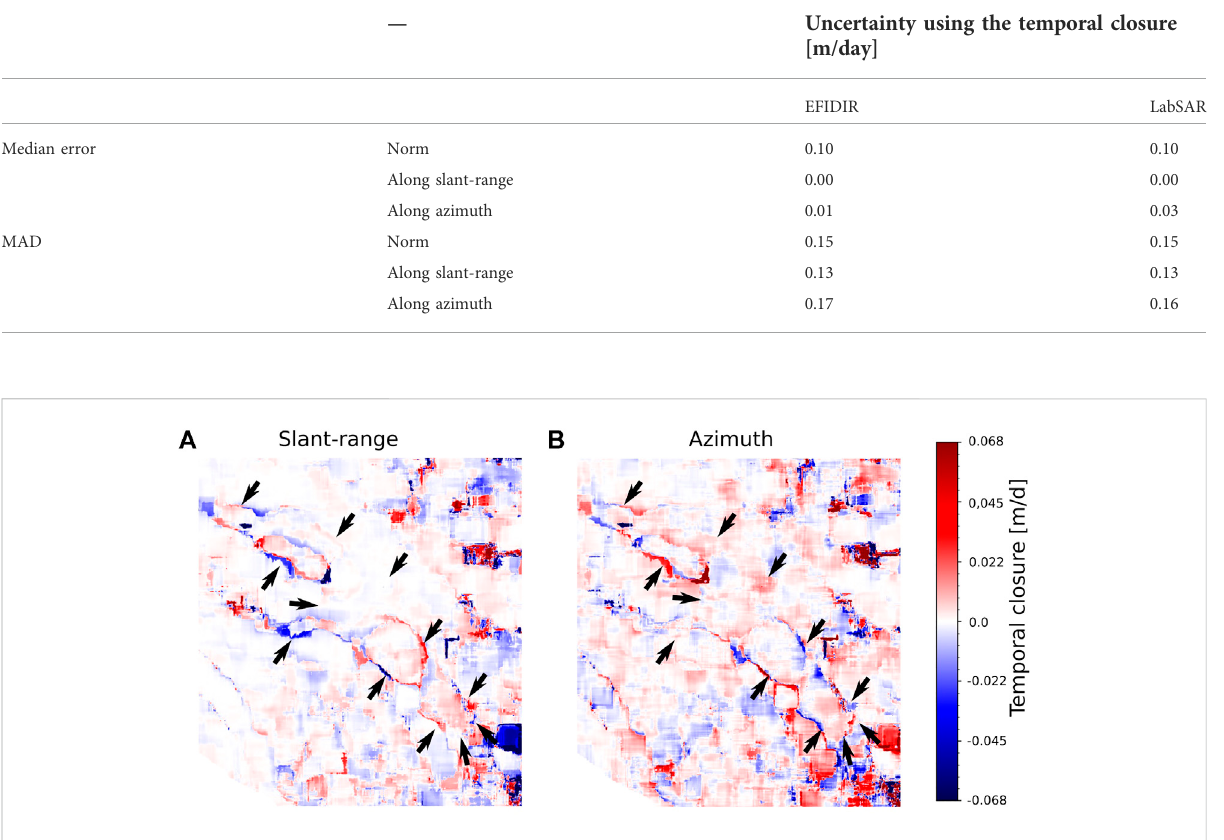
TABLE 4 Comparison of the MAD and MdE of the temporal closure of the displacements for the slant-range and azimuth direction computed using the EFIDIR and LabSAR approaches. The norm corresponds to the norm of the temporal closure error vector de fi ned in Eq. 7. The results are in